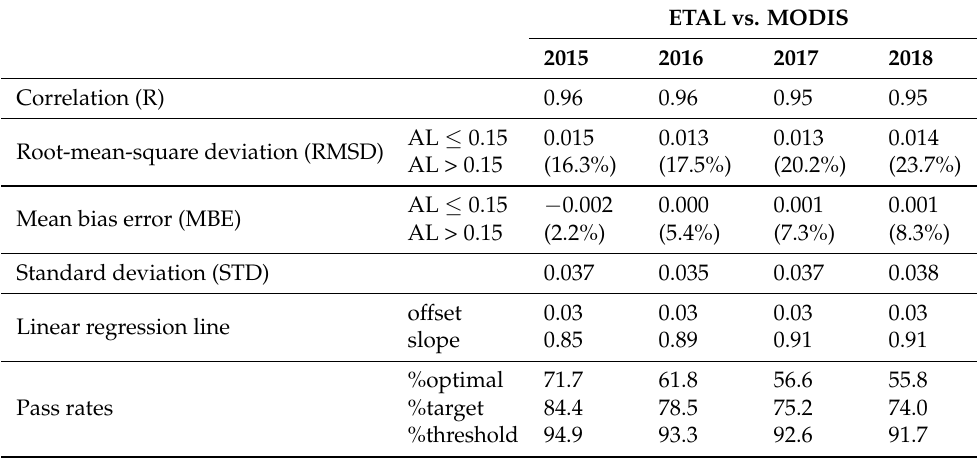
Table 11. Performance statistics between ETAL versus MODIS products during the overlap period (2015–2018). Absolute MBE and RMSD are calculated over albedo values less 0.15 while relative MBE and RMSD (in %) are calculated over albedo values greater than